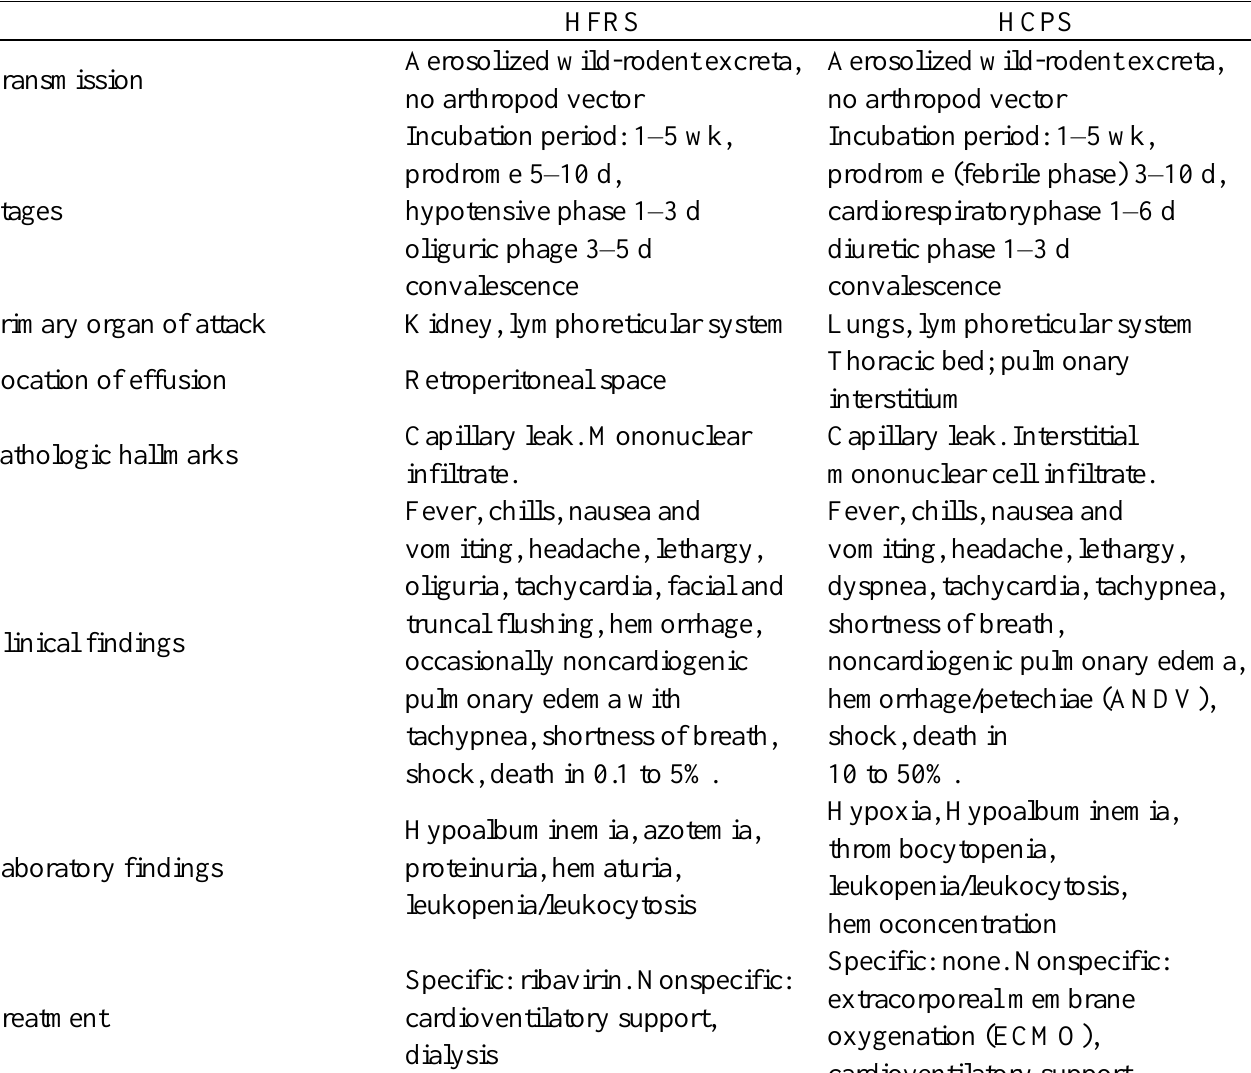
Table 2. Similarities and differences between HFRS and